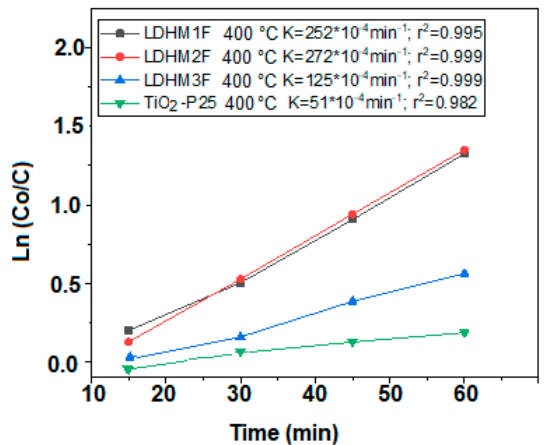
Figure 10. Pseudo-first-order degradation kinetics for 80 ppm of 2,4,6-trichlorophenol with activated layered double hydroxides and TiO 2 -P25.